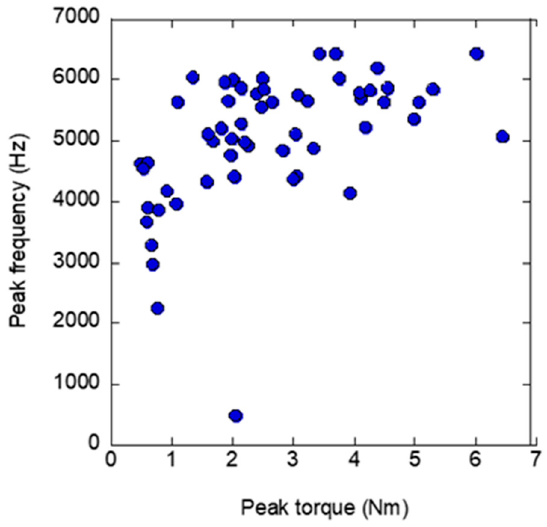
Figure 6. Relationship between peak torque and peak frequency for polyaxial pedicle screws.